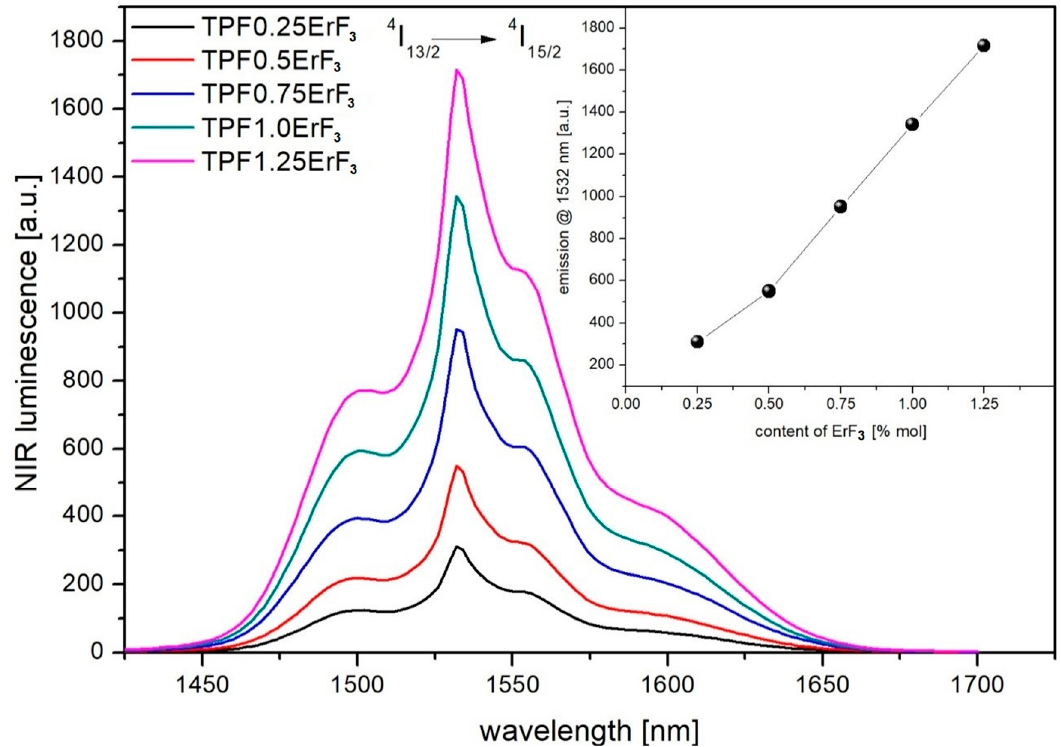
Figure 14. 1553 nm emission spectra of oxyfluoride phospho-tellurite glass with varying ErF 3 content. (inset) The intensity changes of 1553 nm emission band as a function of ErF 3 concentration.